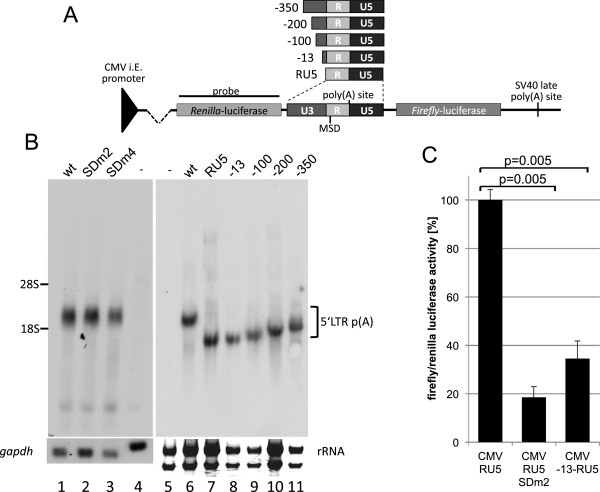
Polyadenylation at the 3′LTR is splice-donor-independent,and 13 nucleotides from U3 are sufficient to promote polyadenylation. (A) Schematic representation of the U3 deletion reporter plasmids used for analysis of polyadenylation at the 3′LTR and the position of the Northern blotting probe. (B) Northern blotting analysis of RNA from HEK 293T cells transfected with pHSRV13 and SDm2 or SDm4 derivatives. The RNAs were preferentially polyadenylated at the 3’LTR polyadenylation site. Neither SDm2 nor SDm4 influenced the poly(A) site selection. To analyse determinants of the poly(A) selection, the U3 region (777 nucleotides) was shortened to encompass nucleotides from −350, -200, -100, or −13 to +1. In addition, a plasmid encoding the RU5 region with a complete deletion of U3 was analysed. rRNA amounts are shown as loading control, since the RU5 and −13 signals migrate at the same height as GAPDH RNA. (C) Luciferase assay of cells transfected with CMV-RU5, CMVRU5-SDm2, and CMV -13RU5 showing that introns, exons, and coding sequences are not required for efficient polyadenylation. Assays were performed in triplicate, and error bars represent the standard deviation from the mean. The significances of the reductions by the MSD mutations were calculated by paired two-sample t-test. p-values are indicated.